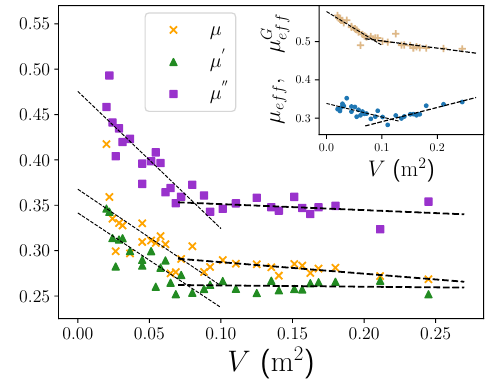
coincides with a bouncy dynamics at the front, e  ciently dissipating energy through a collisional regime, while the tail, moving in a denser regime, ressembles more a smooth bulk